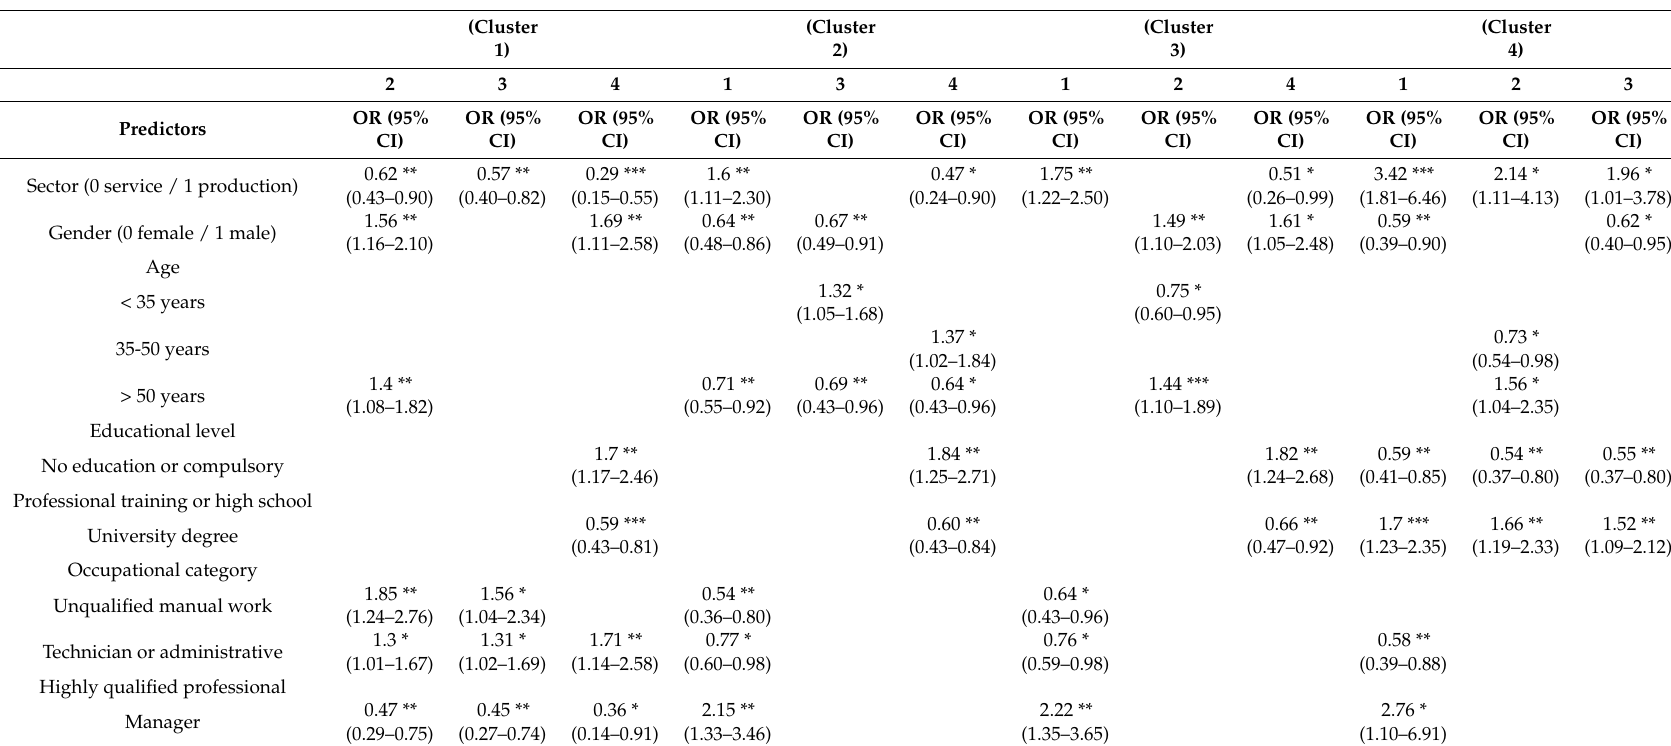
Table 4. Multinomial logistic regression analysis of factors associated with the clusters. Model 2: Eudaimonic (E) Performance employee